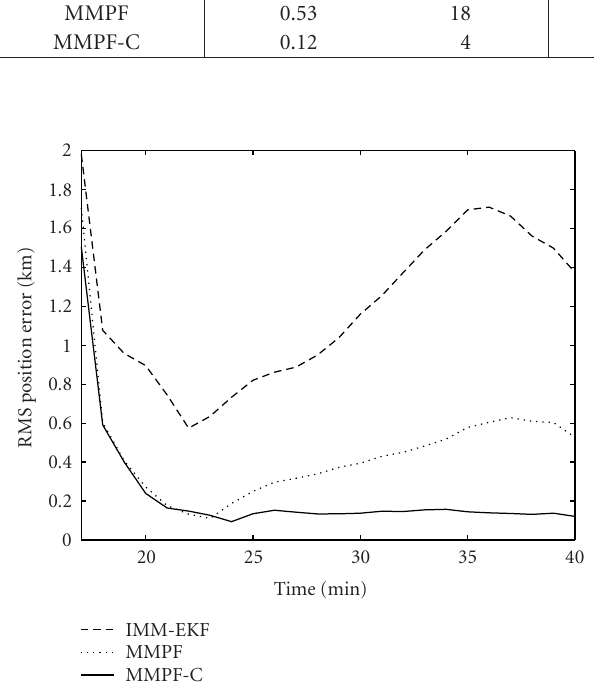
Figure 6: RMS position error versus time for the case of tracking with speed constraint 3 . 5 ≤ s ≤ 4 . 5